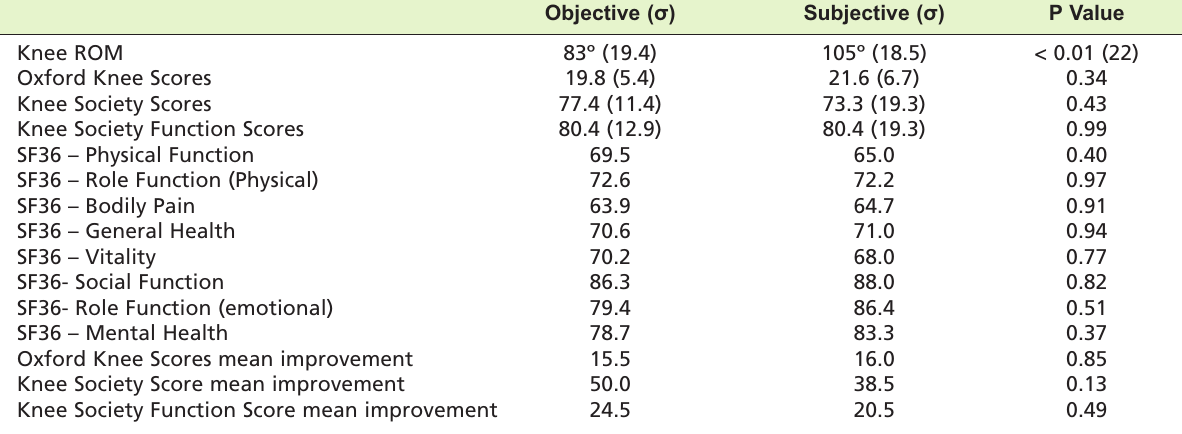
Comparison of Rom and Knee Scores at two years between Objective and Subjective Knee Stiffness Groups Table III: